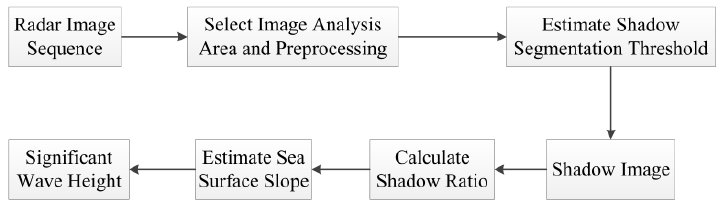
Figure 1. The flowchart of retrieving significant wave height based on the shadow statistical